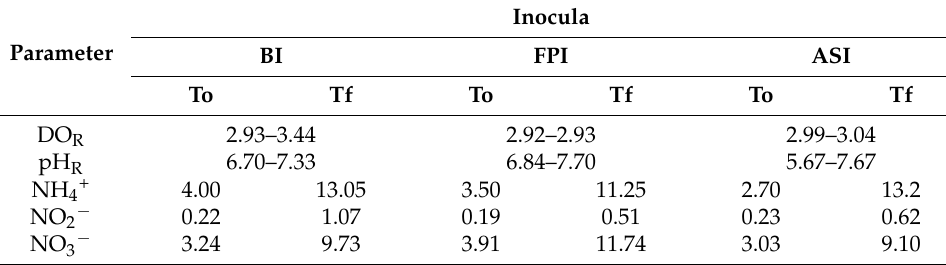
Table 1. Initial and final chemical characterization in bioreactors: DO, NH 4+ , NO 3 − , NO 2 − (mg L − 1 ) and pH